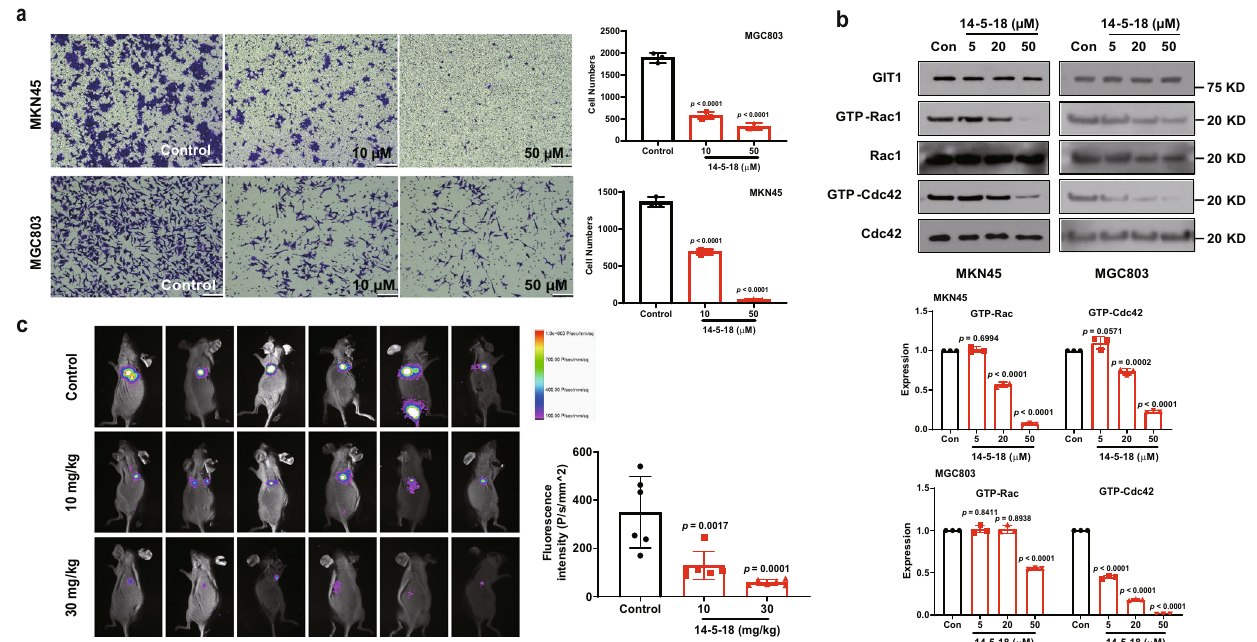
Fig.4|Compound14-5-18inhibitedinvasionofgastriccancercellsinvitroand invivo.a Transwellassayswereemployedtodetecttheanti-invasionabilitiesof 14- 5-18 (10and 50 μ M) in theMGC803(left) and MKN45(right) celllines for24h. The right columns show quanti fi cation, n =3 biologically independent samples. Scale bar=100 µ m. b Expressionlevelsof totalRac1/Cdc42and the activated formsGTP- Rac1/Cdc42 were detected after 14-5-18 was added to MKN45 and MGC803 at concentrationsof5,20and50 μ Mfor24h, n =3biologicallyindependentsamples. c In vivo imaging of nude mice after intravenous injection of luciferase-expressing